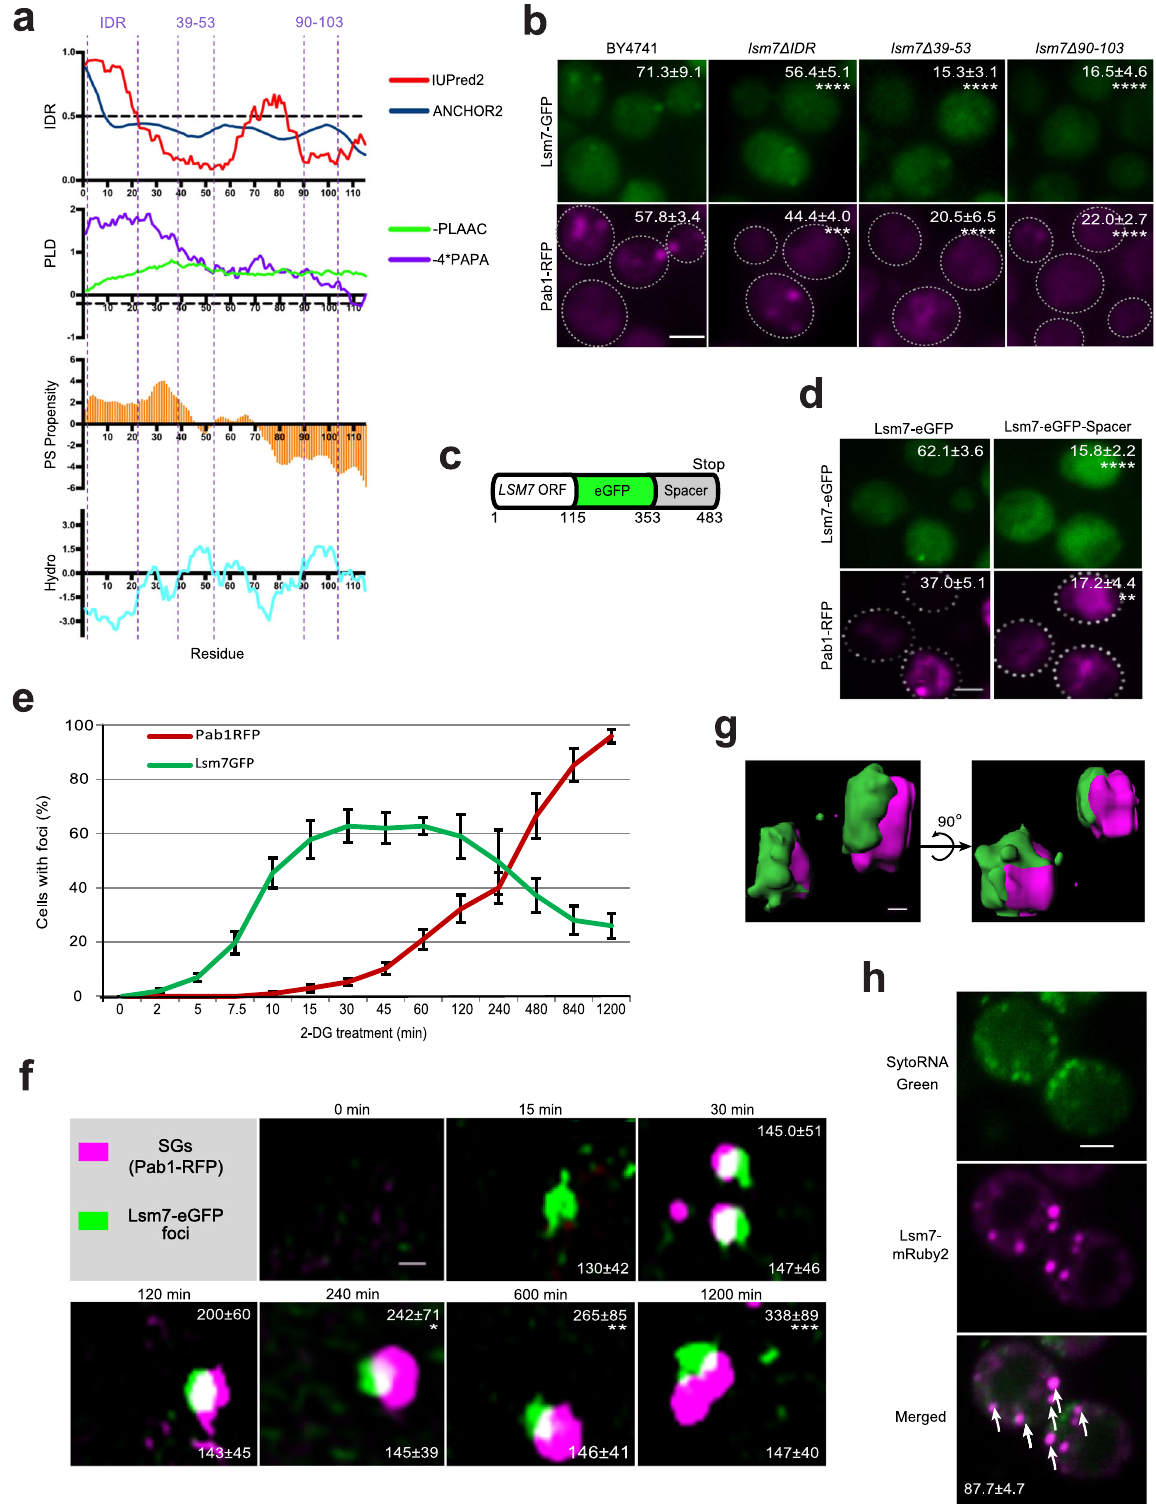
panel) and SGs (Fig. 4b, lower panel) were signi fi cantly decreased under 2-DG stress. Hence, to further con fi rm the role of Lsm7 foci in the SG assembly machinery, we constructed a Lsm7 strain carrying a spacer sequence (the charged middle domain (M) of Sup35) 68 at the C-terminus of Lsm7-eGFP (Fig. 4c). The charged M domain confers solubility to the yeast prion protein Sup35 and has been shown to dampen protein aggregation when fused to